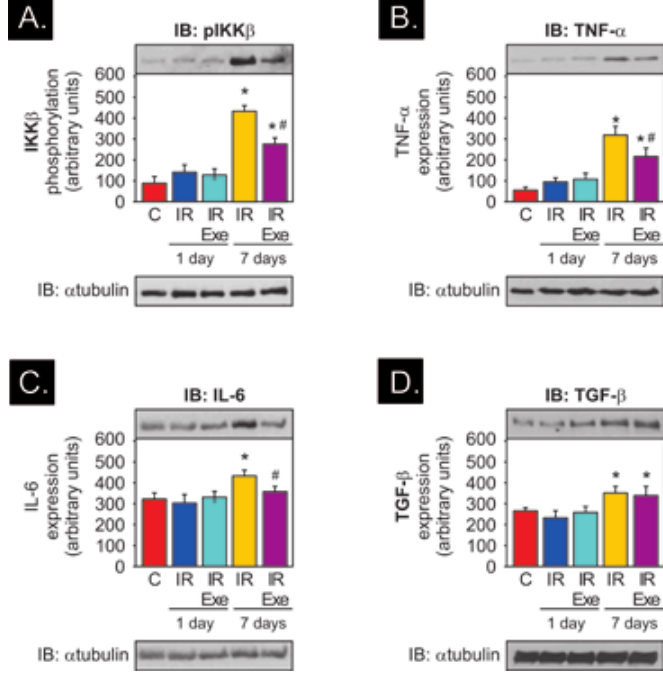
FIGURE 1 - (A) Imunoblotting of pIKK b . (B) Imunoblotting of TNF- a . (C) Imunoblotting of IL-6. (D) Imunoblotting of TGF- b . C: control group (GI). 1 st day: IR: sacrifice of the group that performed only irradiation (GIIa) and IR E.g.: sacrifice of the group that performed irradiation and physical activity (GIIIa). 7 th day: IR: sacrifice of the group that performed only irradiation (GIIb) and IR E.g.: sacrifice of the group that performed irradiation and physical activity